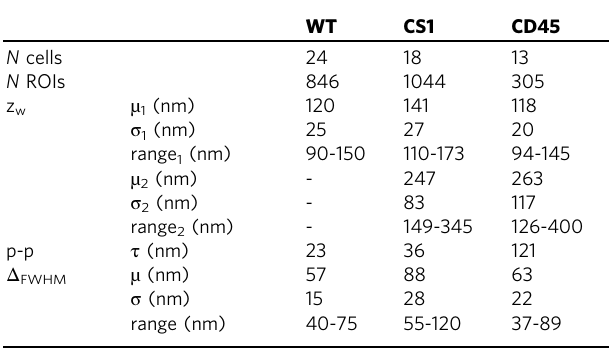
Table 1 Overview of distribution parameters derived from axial receptor